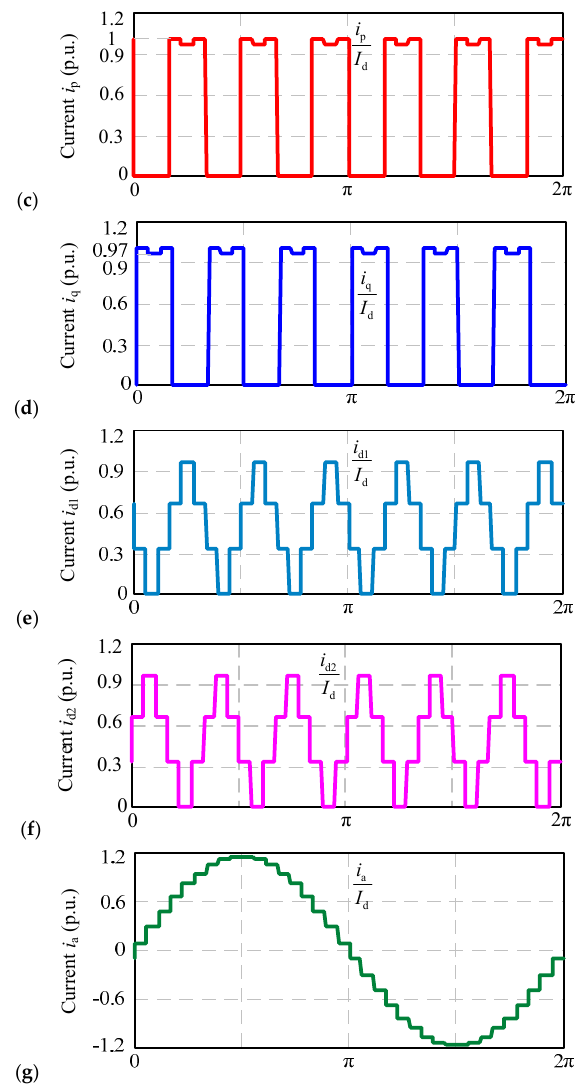
Figure 6. Theoretical currents waveforms. ( a ) Current i m . ( b ) Current i n . ( c ) Current i p . ( d ) Current i q . ( e ) Current i d1 . ( f ) Current i d2 . ( g ) Input line current i a .